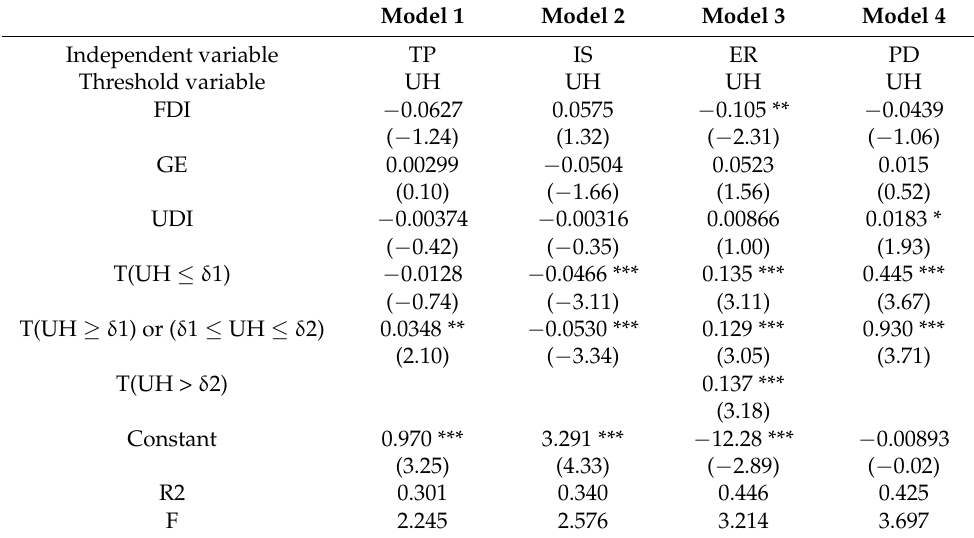
Table 8. Regression results of threshold